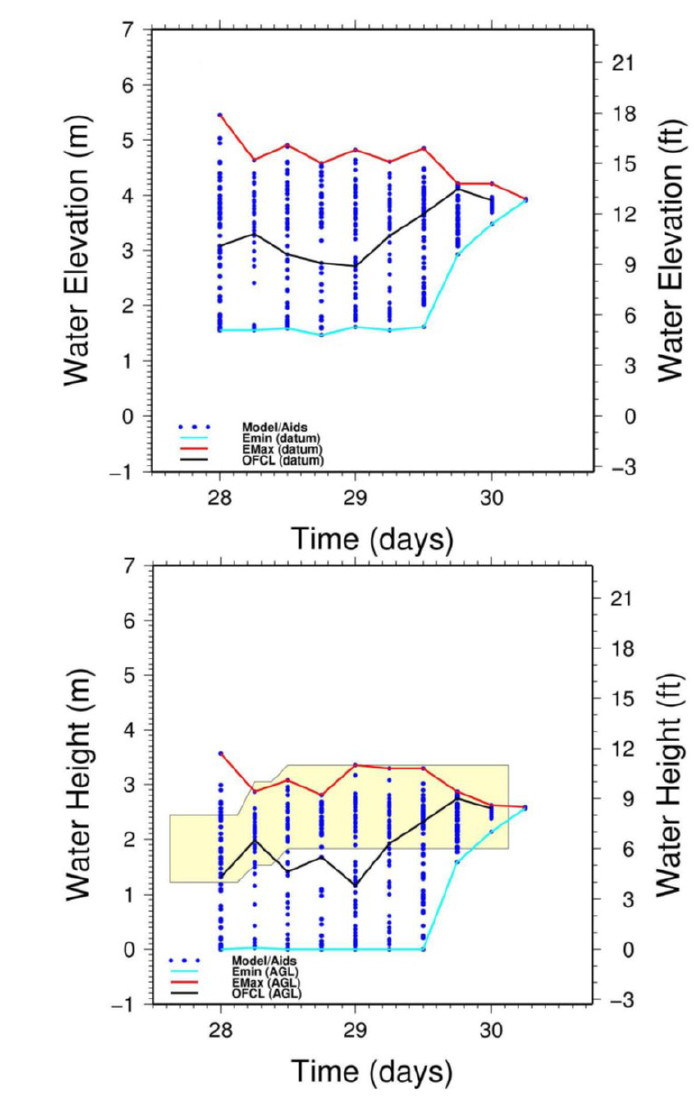
and ( b ) the water height above ground level (AGL), for all the ensemble members for the surge + tides simulations. The light yellow polygon delineates the range of water levels issued in real-time by NHC in its forecast advisories, which encompasses the maximum inundation actually recorded during this storm